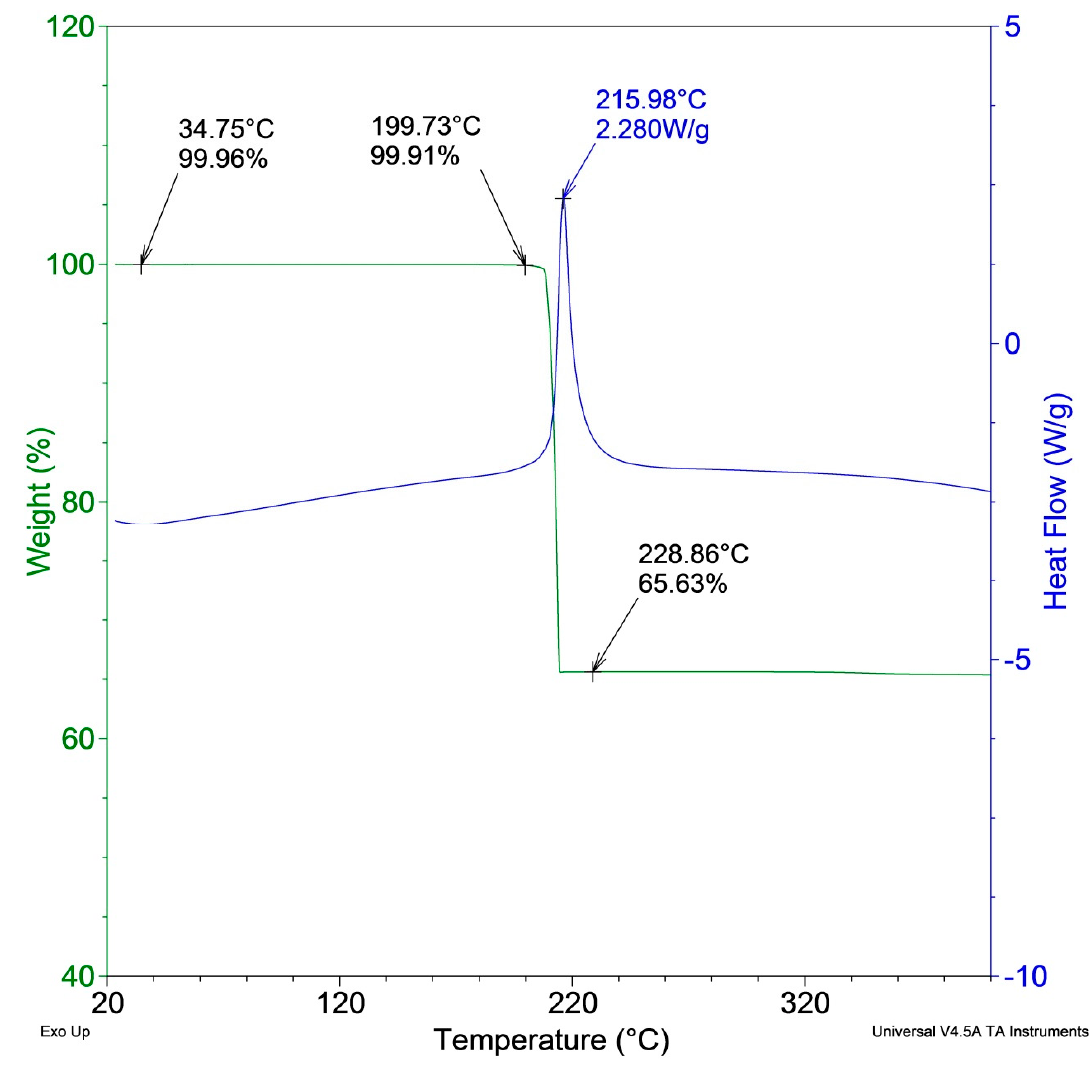
Figure 2. The thermogravimetric/differential scanning calorimetry (TG/DSC) traces (low-temperature fragments) for pure Ag(CCO) complex showing its stability up to ~190 °C.